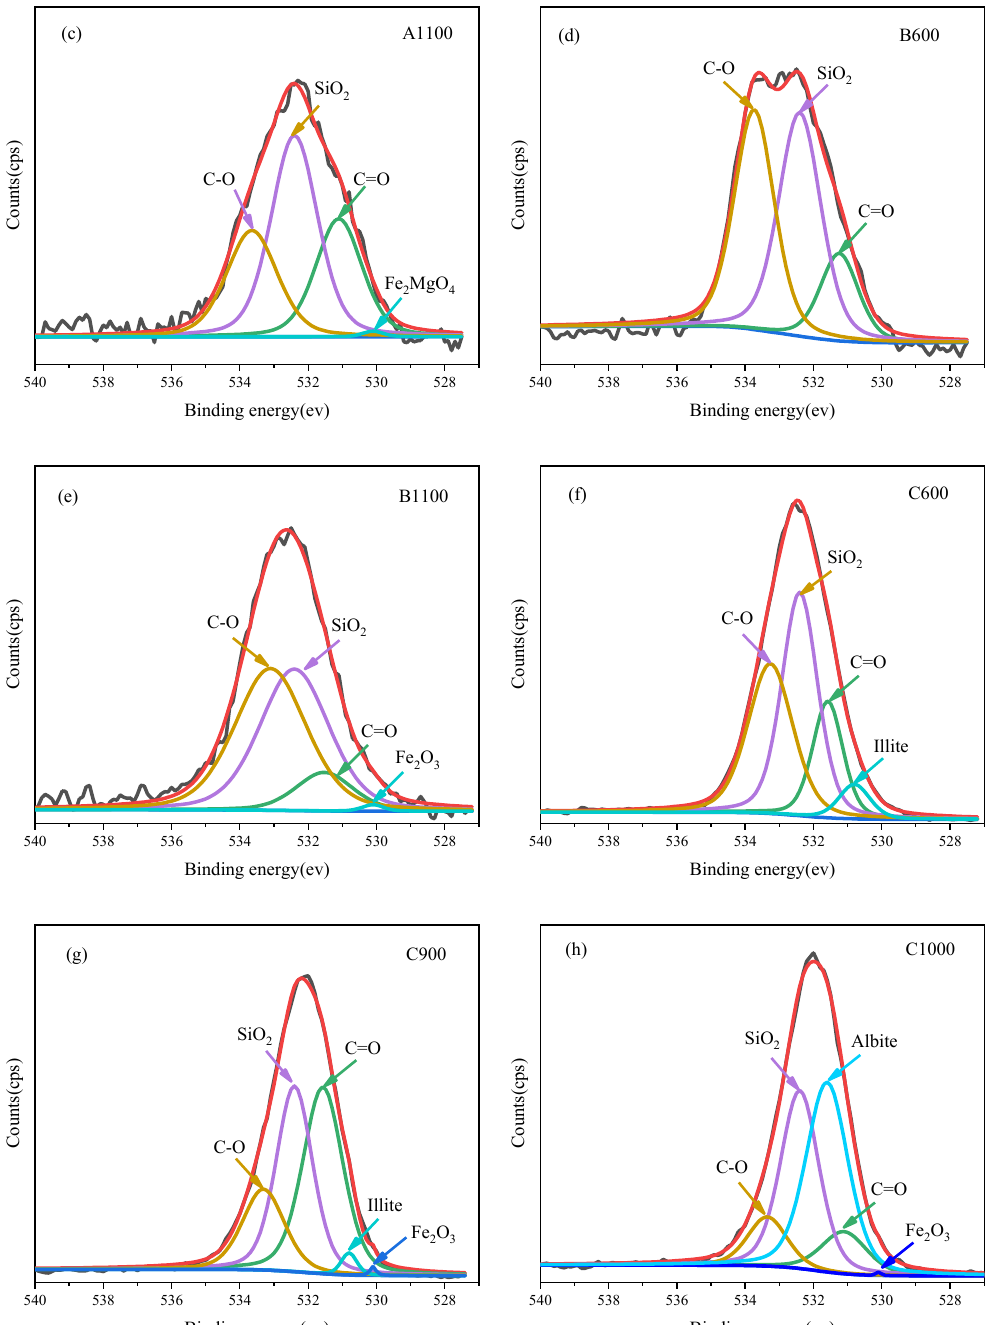
Figure 9. Deconvolution of O1s XPS spectra of coal chars: ( a ) A600; ( b ) A900; ( c ) A1100; ( d ) B600; ( e ) B1100; ( f ) C600; ( g ) C900; ( h ) C1000; The black and red lines denote the original and fitted spectra, respectively.